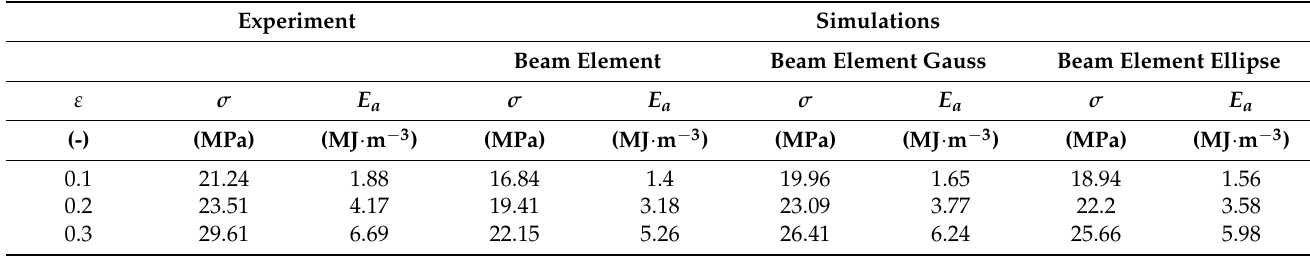
Table 4. Comparison of stress and absorbed energy for different structure deflection. Experiment Simulations Beam Element Beam Element Gauss Beam Element